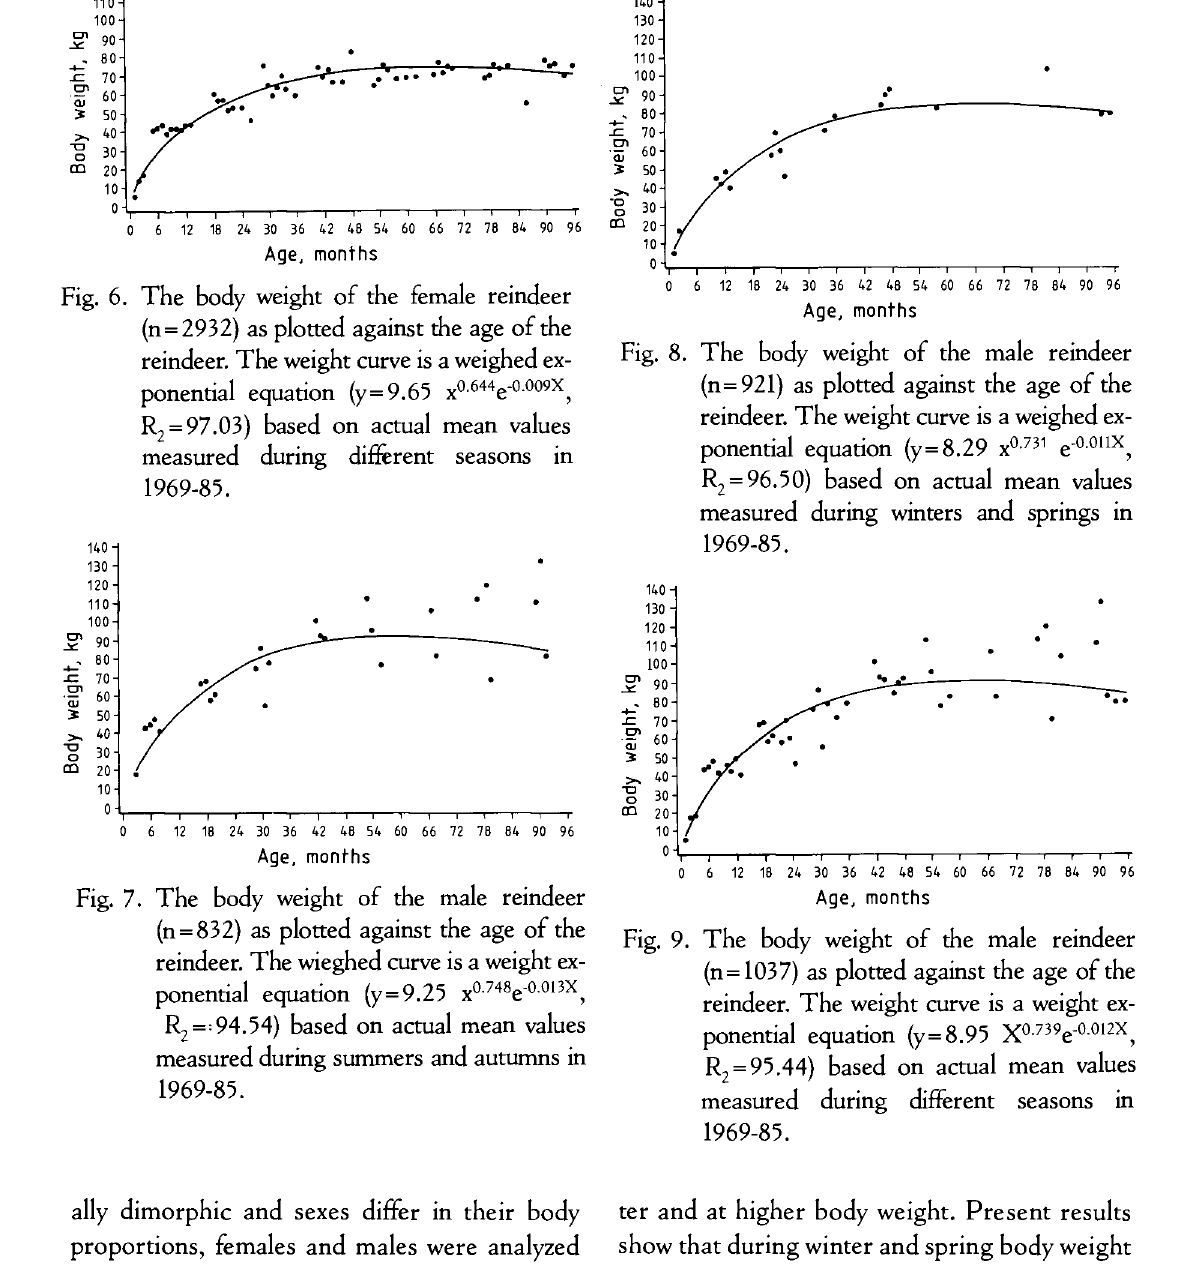
Fig. 9. The body weight of the male reindeer (n=1037) as plotted against the age of the reindeer. The weight curve is a weight ex ponential equation (y=8.95 X 0 - 739 e-°- 012X , R = 95.44) based on actual mean values 2 measured during different seasons in